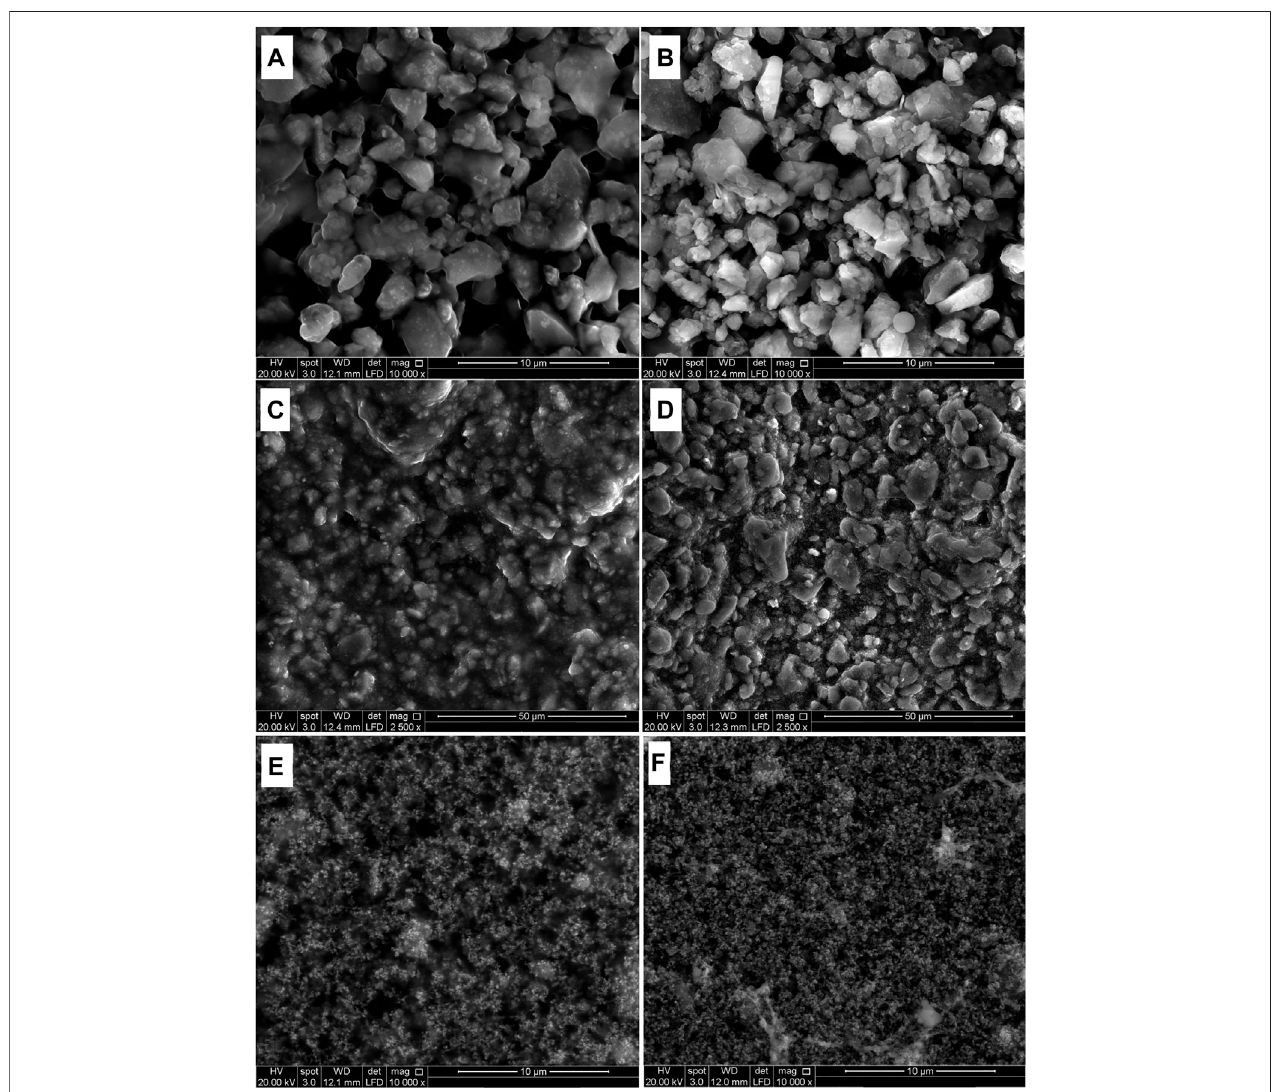
FIGURE 5 | SEM images of alkyd resin mixed with PB29 (A,B) , PG18 (C,D) , and PY37 (E,F) , before aging (left) and after 1,008 h aging (right) .